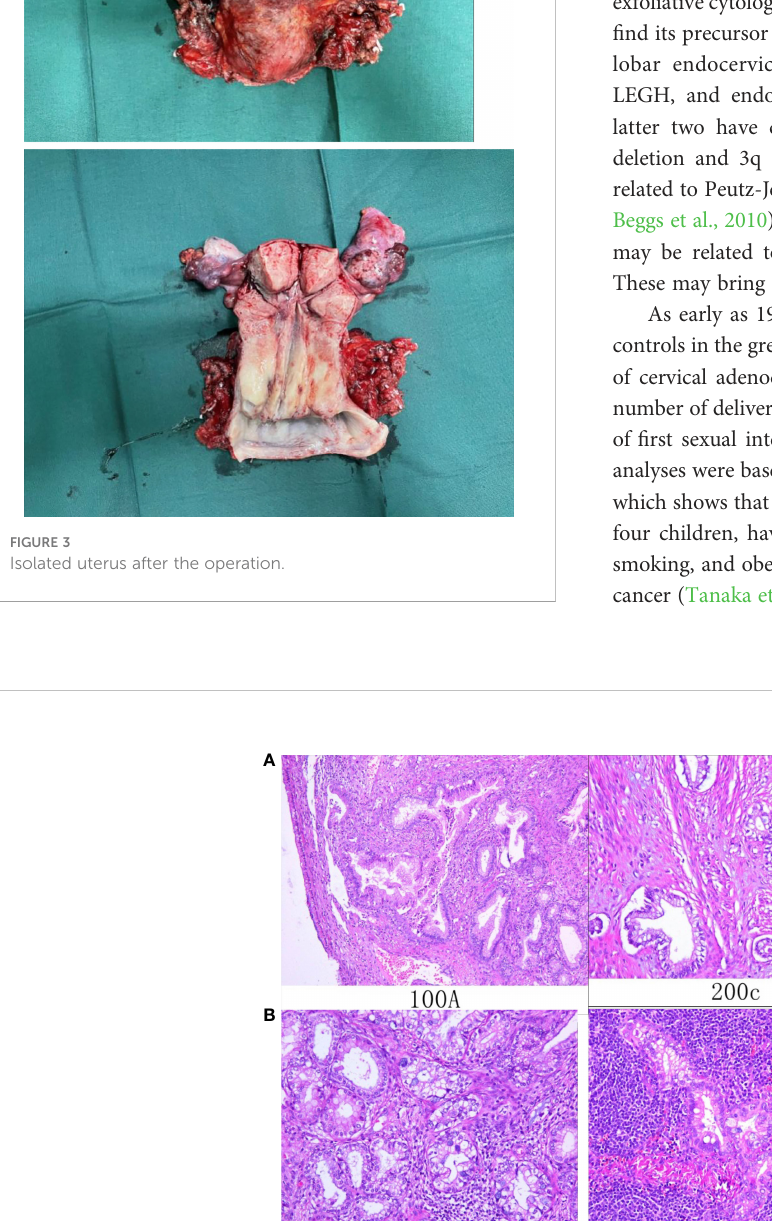
FIGURE 4 Histological ( A – D ; hematoxylin and eosin staining) results. (A) Microscopic examination showed that atypical glands are irregular and expand with gastric differentiation. (B) The tumor showed gastric differentiation, including an atypical nucleus and abundant eosinophilic cytoplasm that was transparent or pale. (C) The tumor invaded the myometrium. (D) Tumor cells metastasized to local lymph nodes.